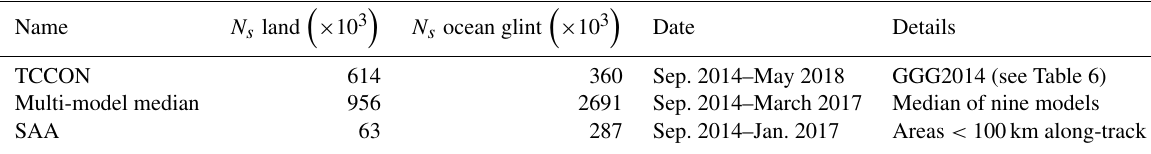
Table 2. Overview of the truth proxy training data sets for v9.